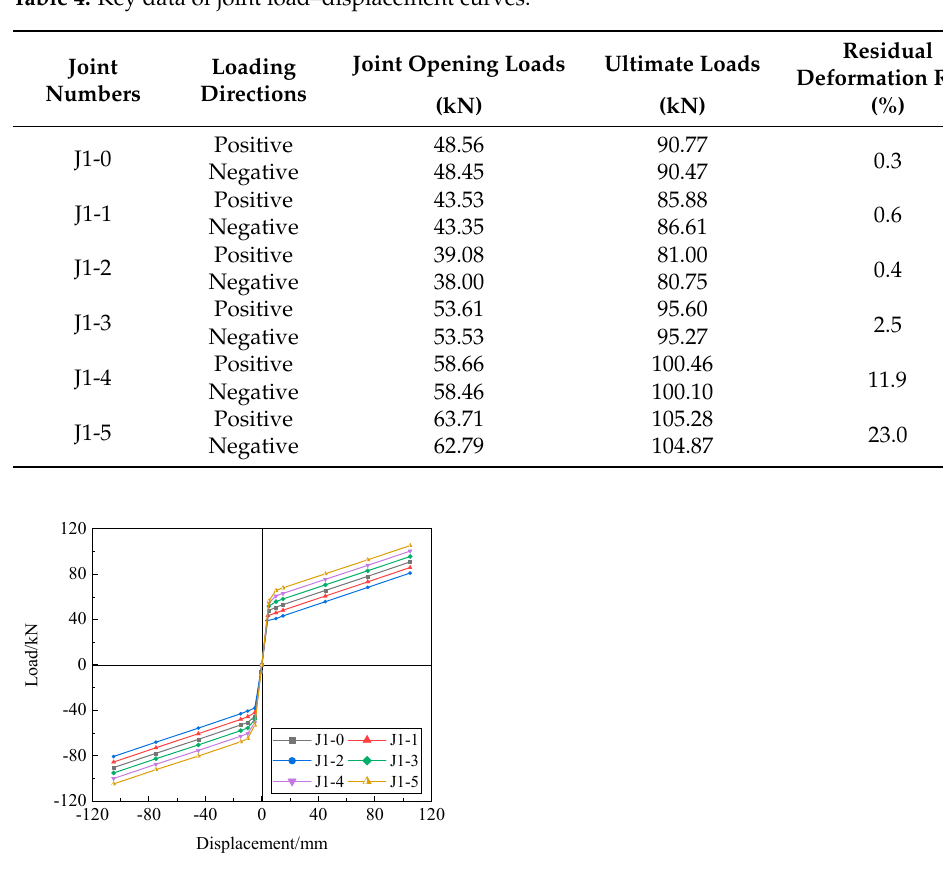
Figure 16. Envelope curves of joints.